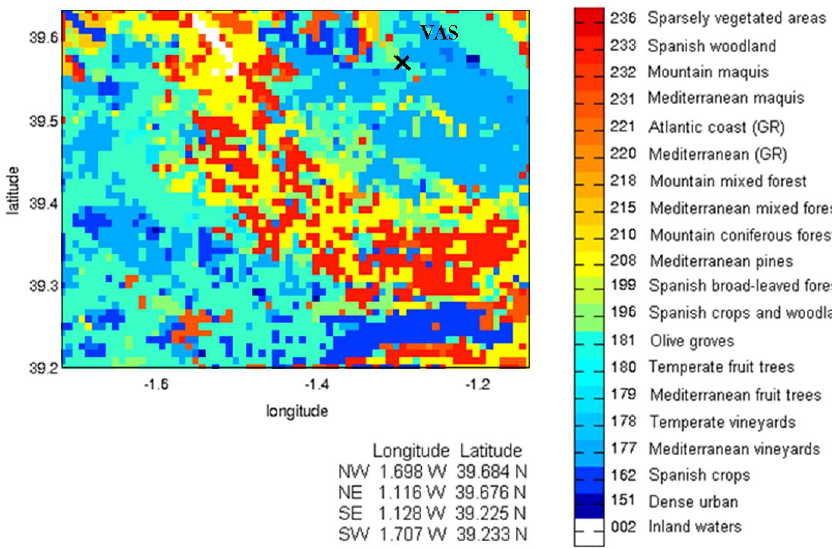
Fig. 2. ECOCLIMAP land cover over the 50 × 50km 2 .